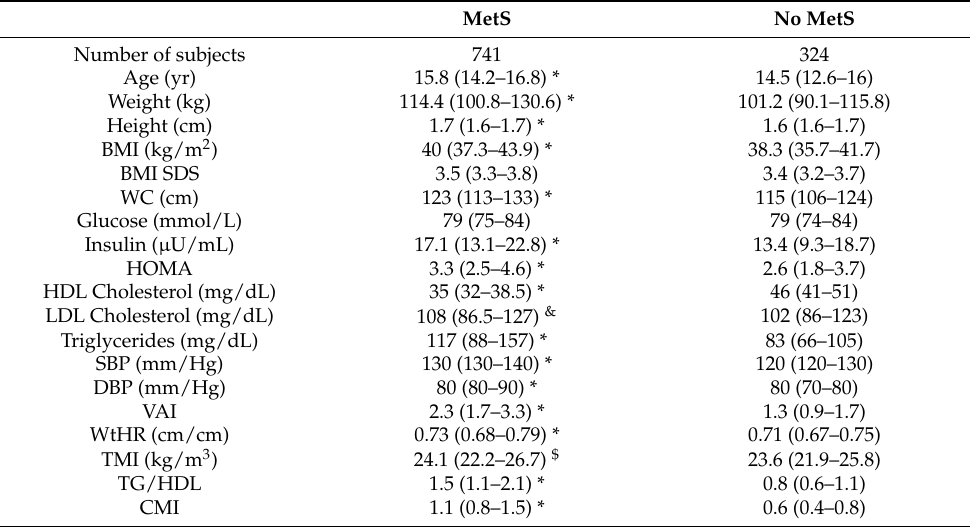
Table 2. Clinical and biochemical data subdivided according to the presence or absence of MetS. Data are expressed as median (interquartile range).